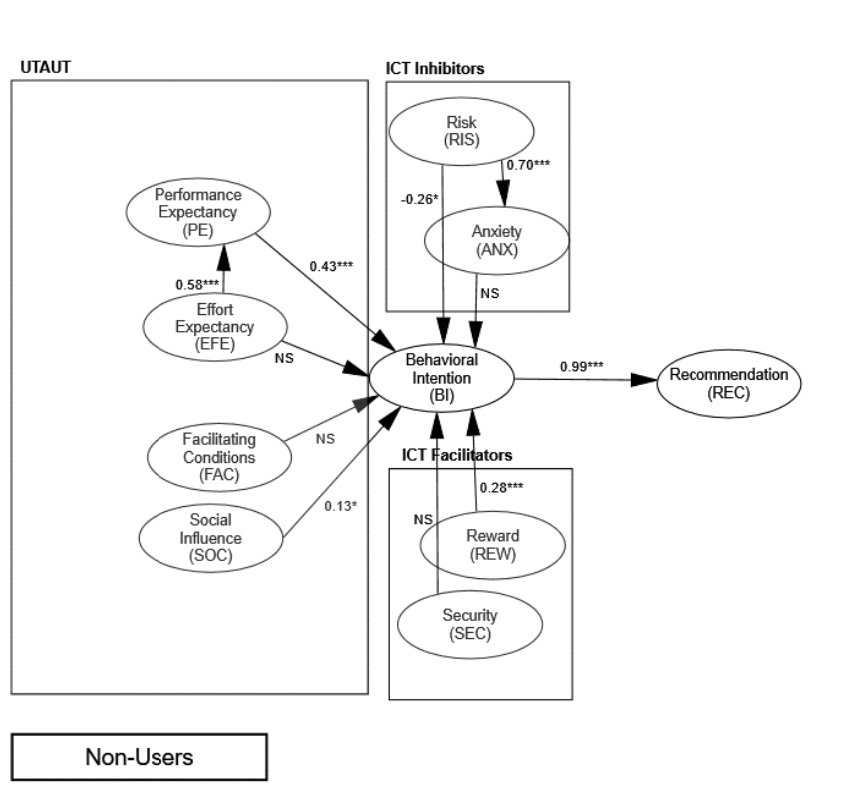
Figure 3. Validated conceptual model—Non-Users. p < 0.1, * p < 0.05, ** p < 0.01, *** p < 0.001, NS: Non-Significant.